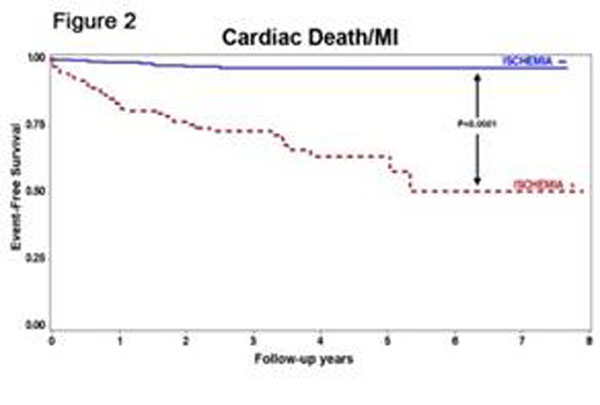
Cardiac Death/MI